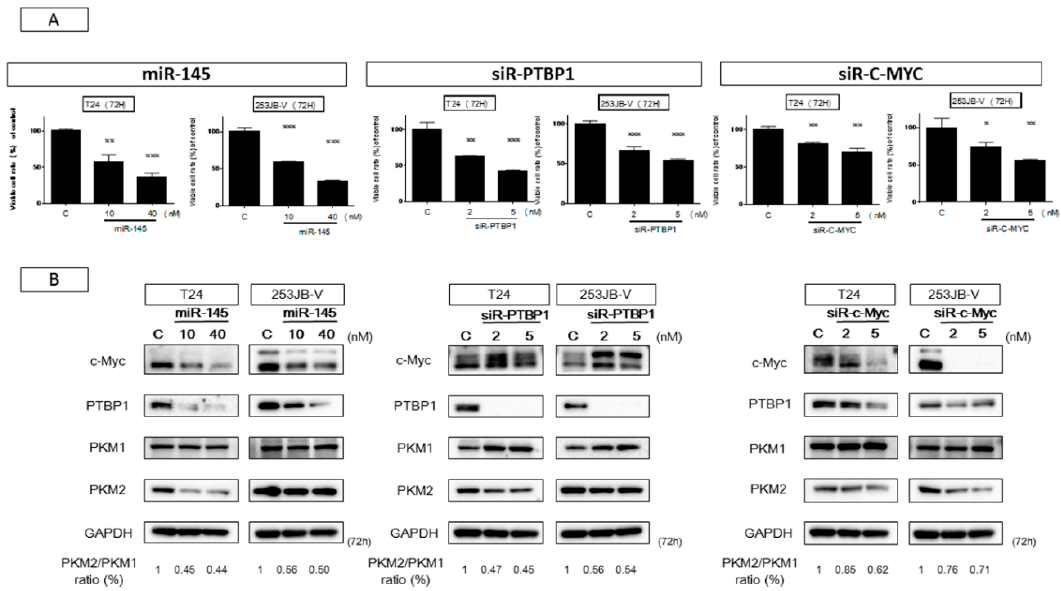
Figure 4. miR-145 impaired PTBP1/PKMs axis in the Warburg effect through downregulation of c-Myc. ( A ) Cell viability after treatment of miR-145 (10 nM, 40 nM), siR-PTBP1 (2 nM, 5 nM), and siR-c-Myc (2 nM, 5 nM) in both cells at 72 h; ( B ) Expression of Warburg effect-related proteins estimated by Western blot analysis after each treatment in T24 and 253JB-V cells, and PKM2/PKM1 ratio calculated based on densitometric values of PKM1 and PKM2. Numbers represent ratios when control values were taken as 1.000. * indicates p < 0.05; ** p < 0.01; *** p < 0.001.